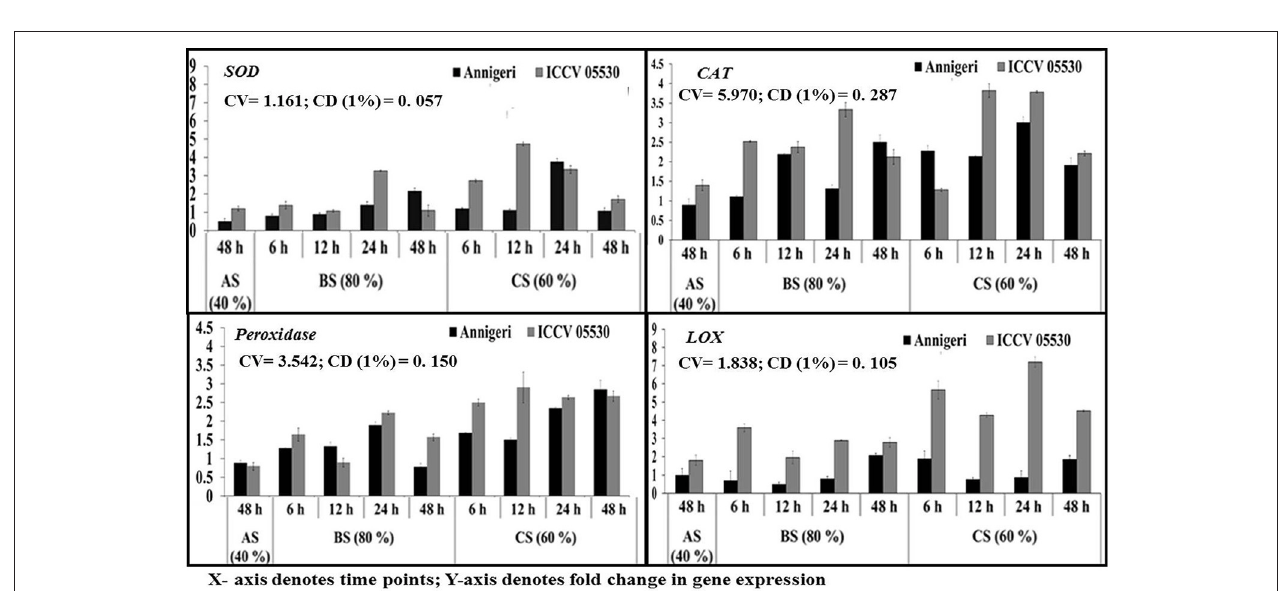
FIGURE 5 | RT-qPCR analysis of differentially expressed genes involved in phenylpropanoid pathway in chickpea during interaction with S. rolfsii at limiting (40%), lower optimum (60%), and optimum (80%) soil moisture conditions. Time (in hours) and fold change in gene expression are shown on X and Y axis, respectively. Standard error of three biological replications was calculated and represented as error bar. AS, BS, and CS denote abiotic stress, biotic stress, and combined stress respectively. The statistical significance of gene expression in between the control and treated seedlings was calculated by factorial ANOVA.